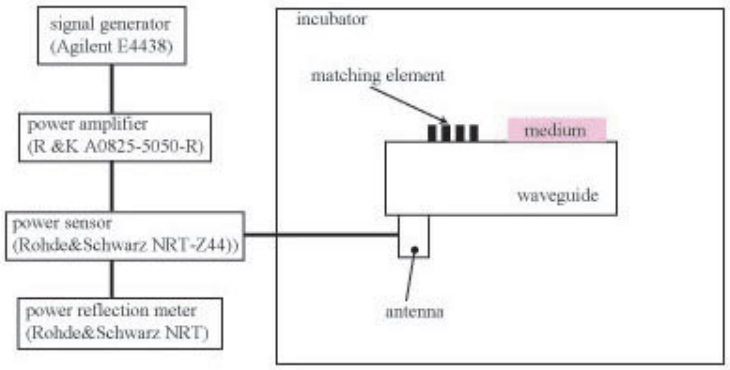
FIGURE 3 . Schematic view of the exposure